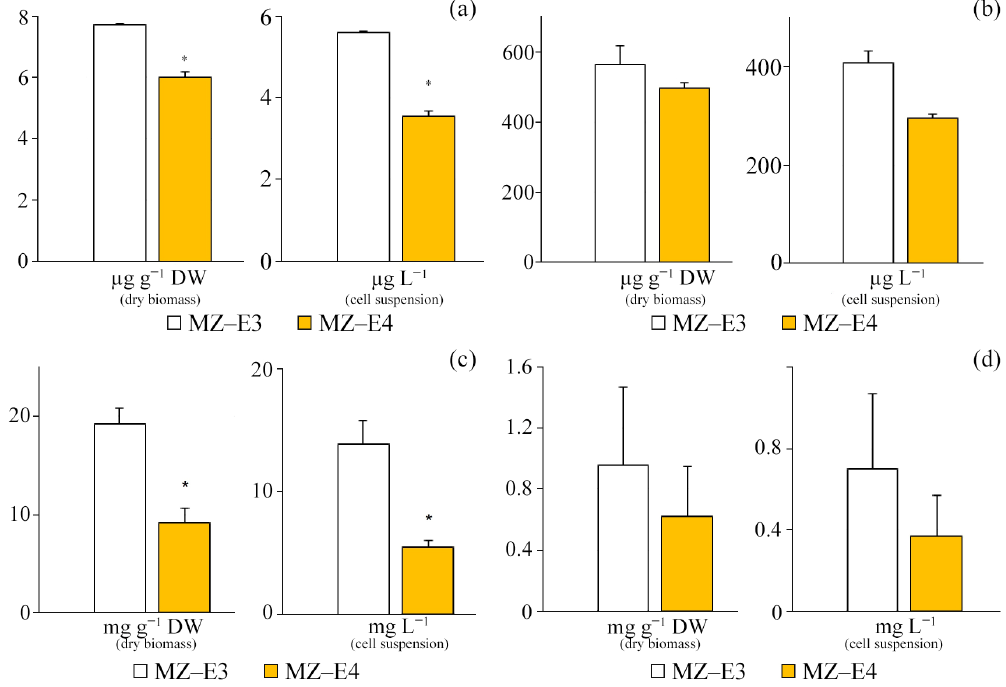
Figure 7. Chlorophyll and secondary metabolites are in the dry biomass and cell suspension of Vischeria vischeri strains (MZ–E3; MZ–E4). ( a ) Retinol. ( b ) α -tocopherol. ( c ) Carotenoids. ( d ) Chloro- phyll a . Medium: BBM; culture volume: 250 mL; incubation time: 25 days; M ± S.E., n = 3; * the differences are significant relative to MZ–E3 (p ≤